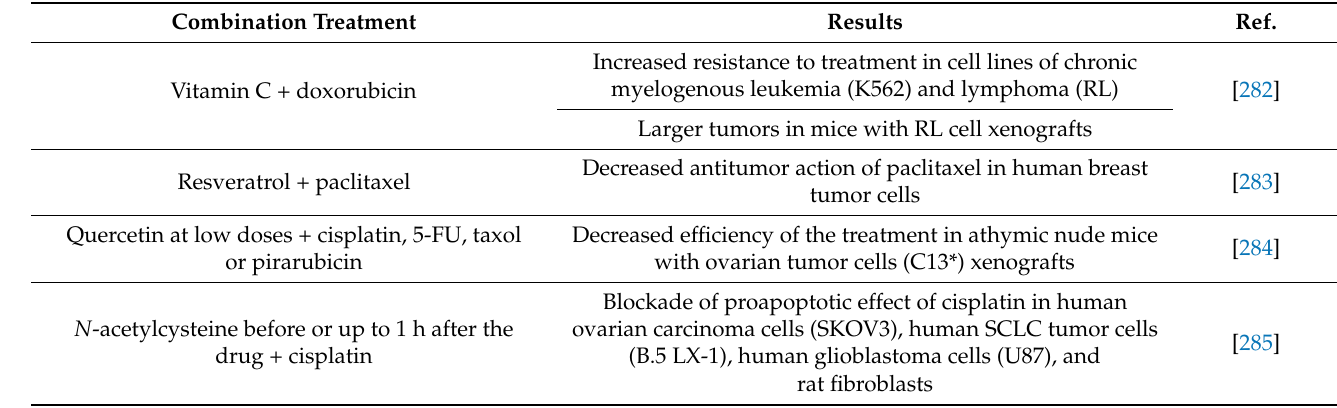
Table 3. Clinical trials conducted using combination treatment of antioxidants with chemotherapeutic agents. Combination